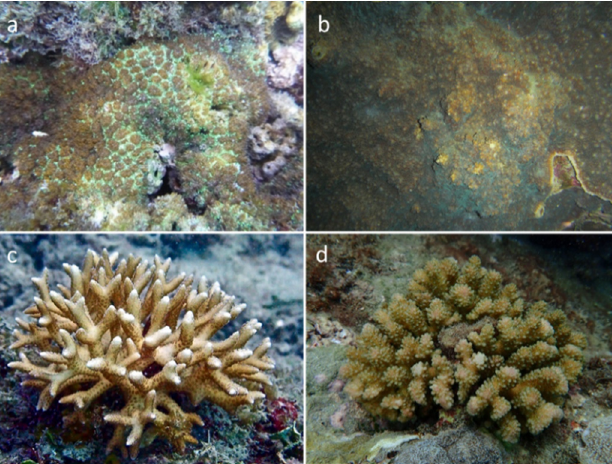
Figure 1. Coral species used in the experiment: ( a ) Galaxea fascicularis ; ( b ) Mycedium elephantotus ; ( c ) Seriatopora caliendrum ; and ( d ) Pocillopora verrucosa .